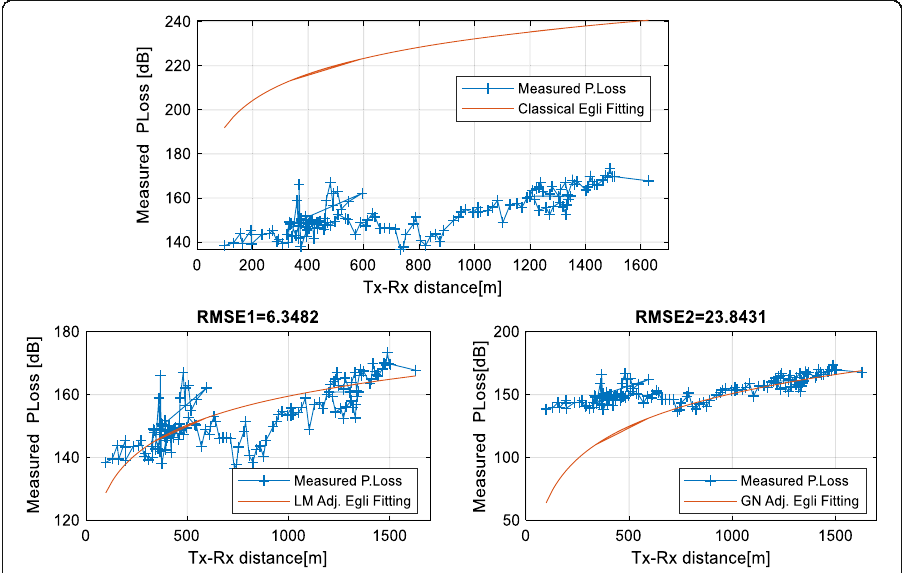
Fig. 5 Measured propagation loss estimation and their error distribution statistics using classical Egli model and adapted Egli model for